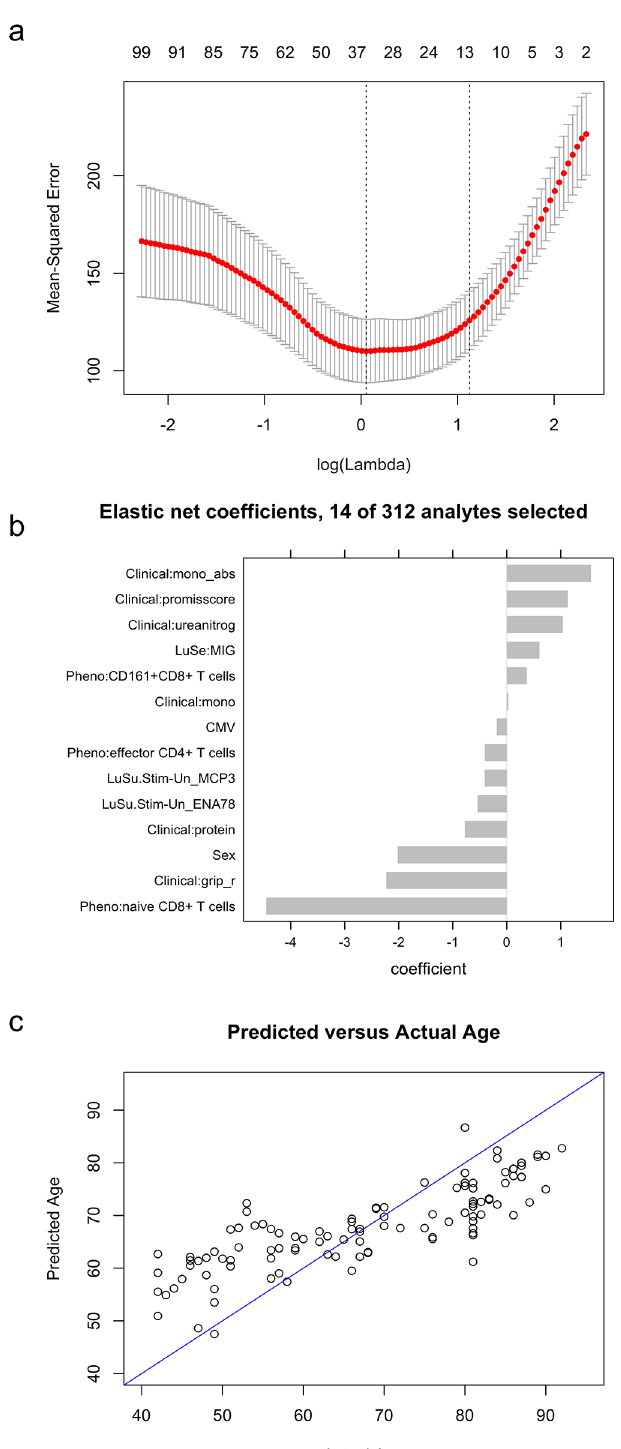
Fig 7. (A) Profile of mean-squared error of elastic-net regression for various values of lambda. For a range of lambdas, an elastic-net regression is fit using 10-fold cross-validation. Vertical dotted lines indicate the value of lambda for which MSE is minimized, and the largest value of lambda within one standard error of that minimum. The numbers along the top border of the graph indicate the number of non-zero parameters that are included in the model for corresponding values of lambda. (B) Results of elastic-net